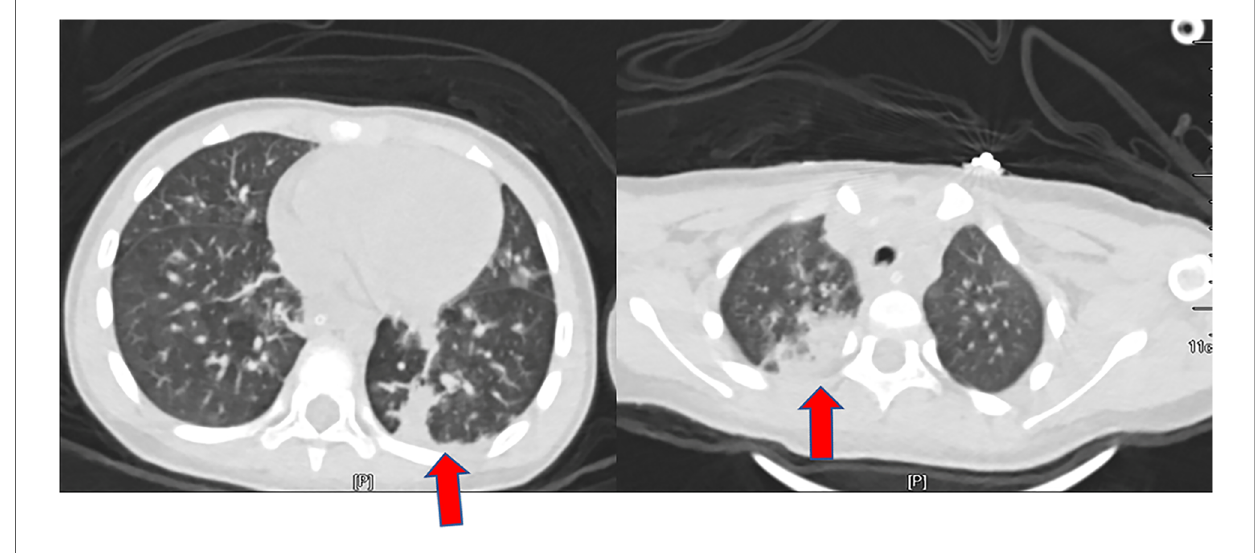
FIGURE 2 The CT scan of the chest performed 2 days after admission showed scattered consolidation.